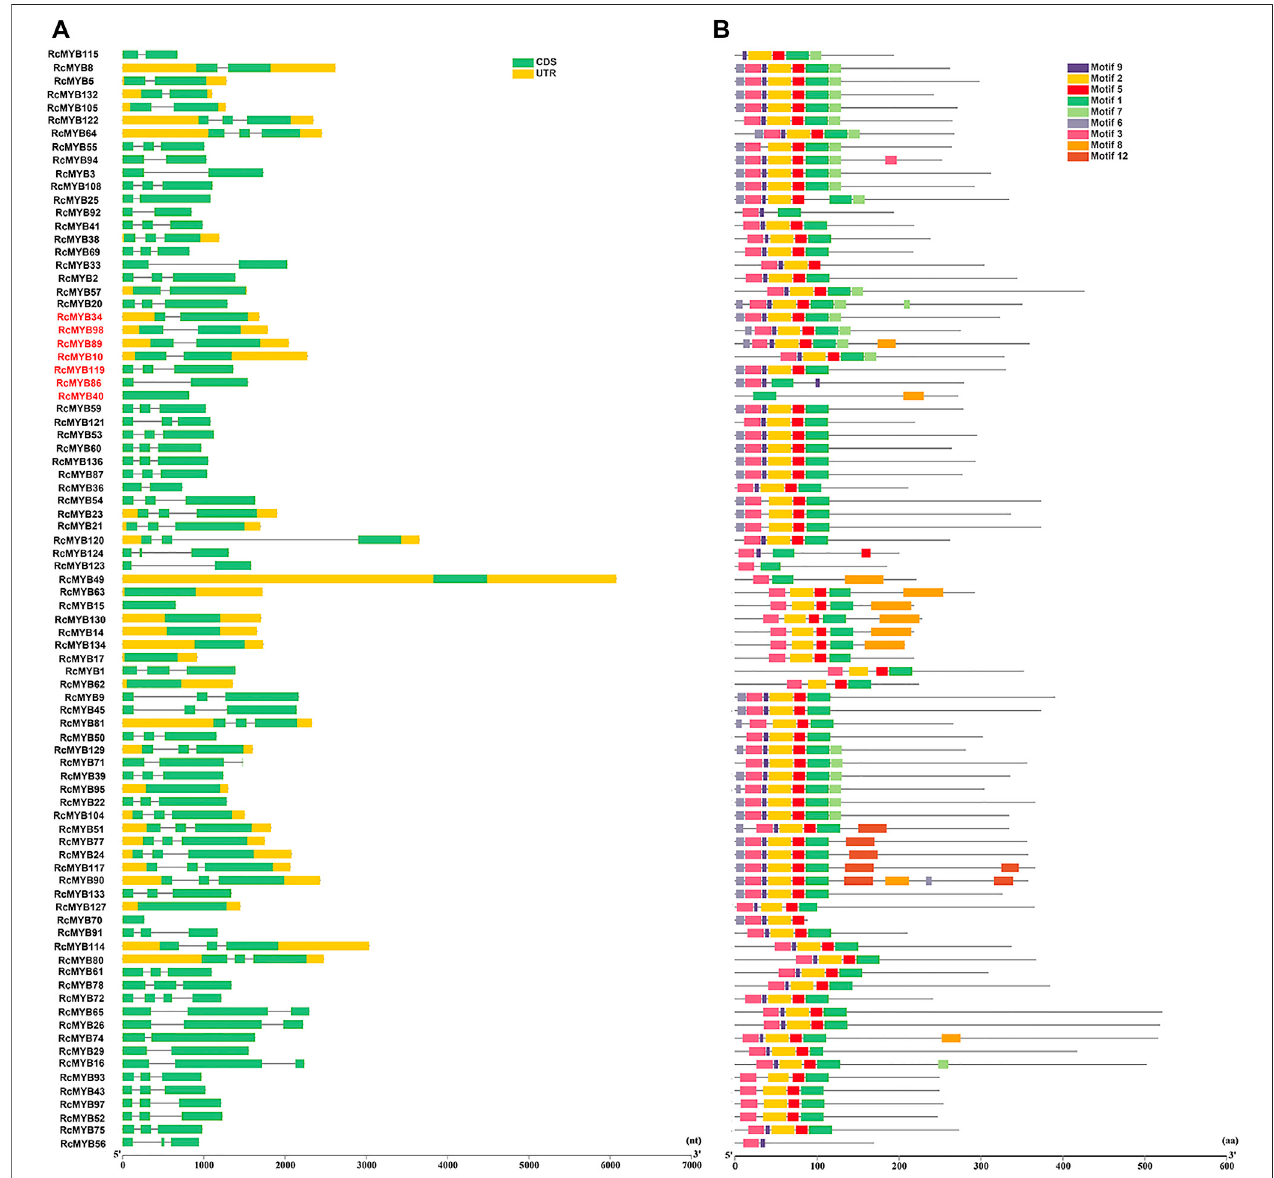
FIGURE 2 | The gene structures and conserved motifs of R2R3 MYB proteins in R.crenulata . (A) The coding sequence (CDS) and untranslated region (UTR) were displayed in different colors, and the lines between boxes represented introns. (B) The phylogenetic tree constructed with RcMYB proteins and conserved domains of the RcMYB family was analyzed by MEME suite. Different colors indicated different